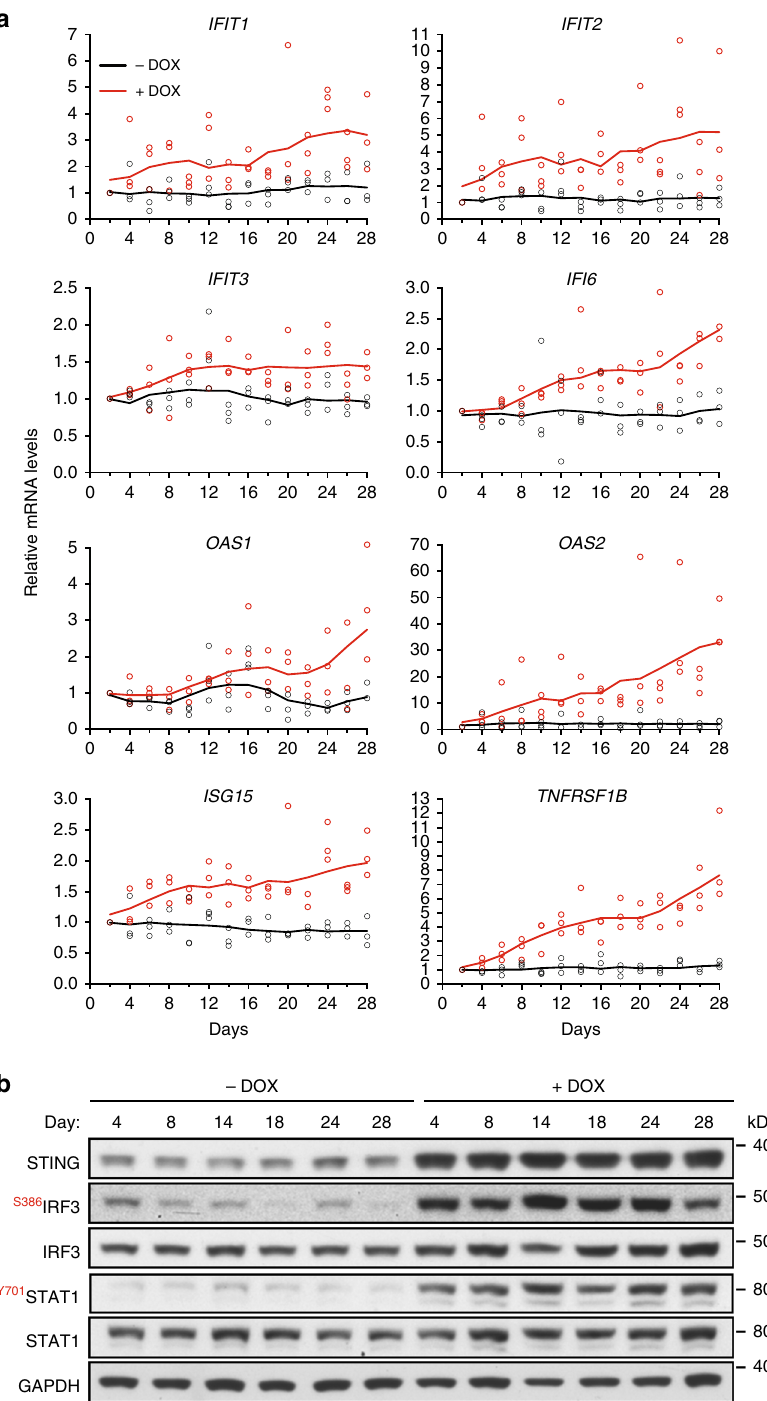
Fig. 4 Time course of innate immune response activation in BRCA2-de fi cient cells. a H1299 cells expressing a DOX-inducible BRCA2 shRNA were grown in the presence or absence of DOX for 28 days. Cells collected every 2 days were subjected to quantitative RT-PCR analyses using primers speci fi c for indicated genes. mRNA levels were expressed relative to the gene encoding β -actin and to day 2 (2 − ΔΔ CT ). n = 3 independent experiments, each performed in triplicates. Each dot represents a single replicate. b Whole-cell extracts prepared at indicated times after DOX addition were immunoblotted as shown. GAPDH was used as a loading control. Phosphorylation sites are indicated in